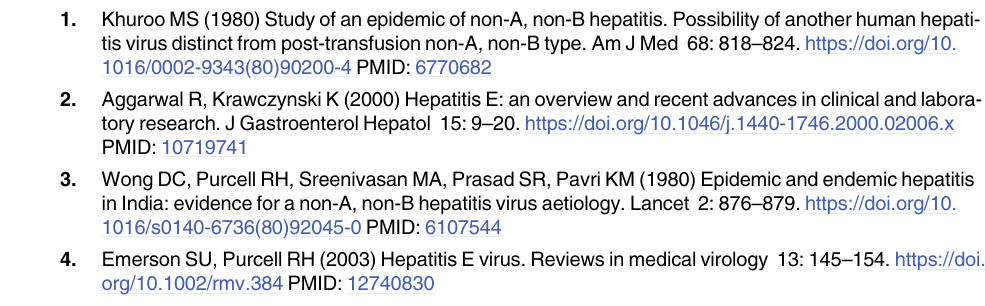
S1 Fig. Flow chart of patient enrolment, laboratory testing and follow-up in the surveil- lance hospitals. Number of patients diagnosed with acute jaundice, provided a blood speci- men and followed up post hospital discharge in the six tertiary hospitals in Bangladesh.